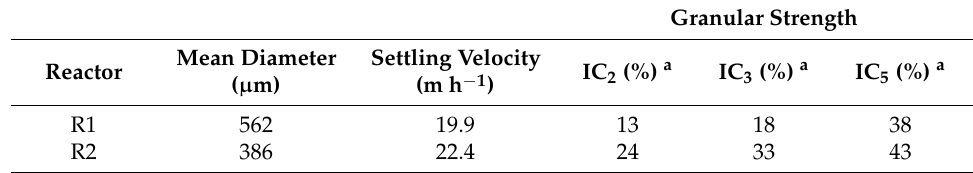
Table 4. Characteristics of developed granules at the end of the study.